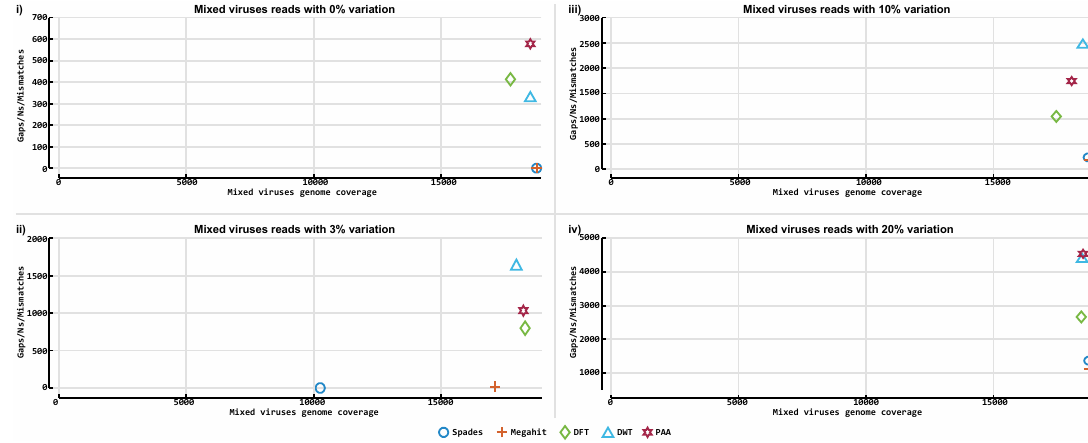
Figure 12. Accuracy of our prototype de novo assembly implementation and two established tools on mixed viruses simulated datasets. The contigs obtained for each assembler were evaluated against the reference genome that was used to generate the simulated data. BLASTn was used to align all contigs to an HIV-1 HXB2 reference genome and determine how much of the particular genome they cover. The y -axis indicates the number of gaps and mismatches that exist in the contigs obtained for each tool, and the x -axis depicts the length of the genome the reported contigs cover. The contigs obtained from the mixed virus simulated dataset were evaluated against the KM198529, KM198528, KM198511, KM198500, KM198486, KU296608, KU296553, KU296549, KU296528, KU296416, KP317952, KP317946, KP317934, KP317923 and KP317922 references genomes. Plots 11- i to 11- iv illustrate results obtained from all assemblers on data with 0%, 3%, 10% and 20% variation levels accordingly.